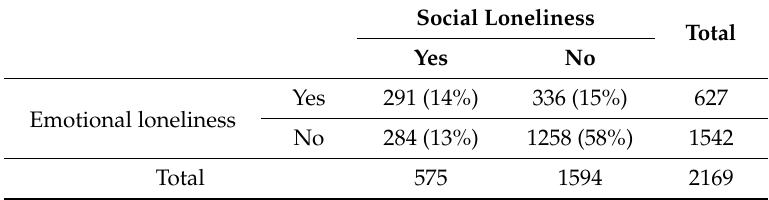
Table 2. Number of participants experiencing emotional and / or social